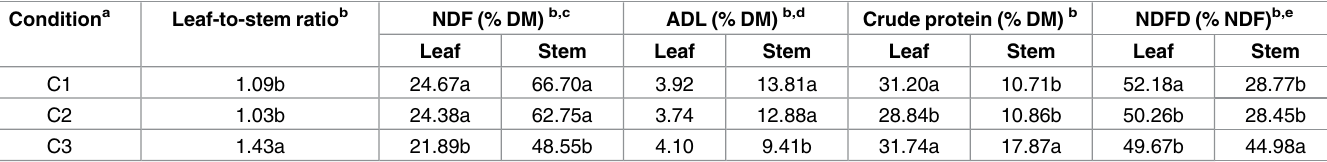
a C1, summer harvest (July 13), full irrigation; C2, summer harvest (July 13), 21 days irrigation suspension prior to harvest; C3 autumn harvest (October 16). b Column mean values followed by different letters were different at P < 0.05 according to Duncan’s multiple range test. c NDF, neutral detergent fiber (DM, dry matter).